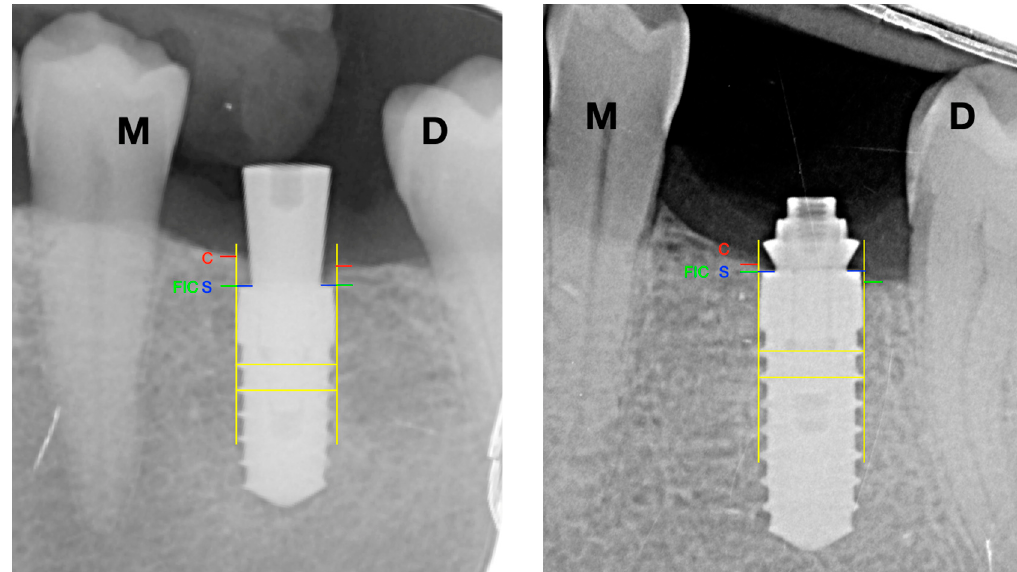
Figure 3. Radiographic analysis. S: implant shoulder; C: bone crest; FIC: first bone to implant contact; M: mesial; D: distal; SC distance: marginal bone level at the crest; S-FIC distance: marginal bone level at the implant.